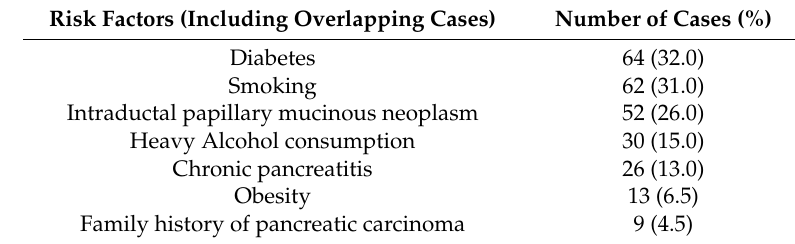
Table 3. Risk factors observed in patients (quoted from Reference [23]).